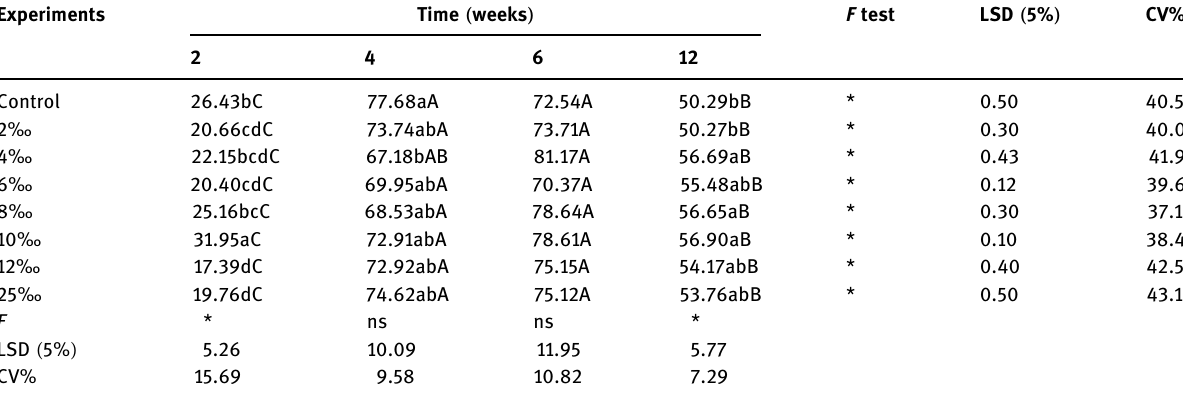
Table 8: Changes in the value of available nitrogen ( mg/kg ) in the soil over the time of salinity and salt concentration